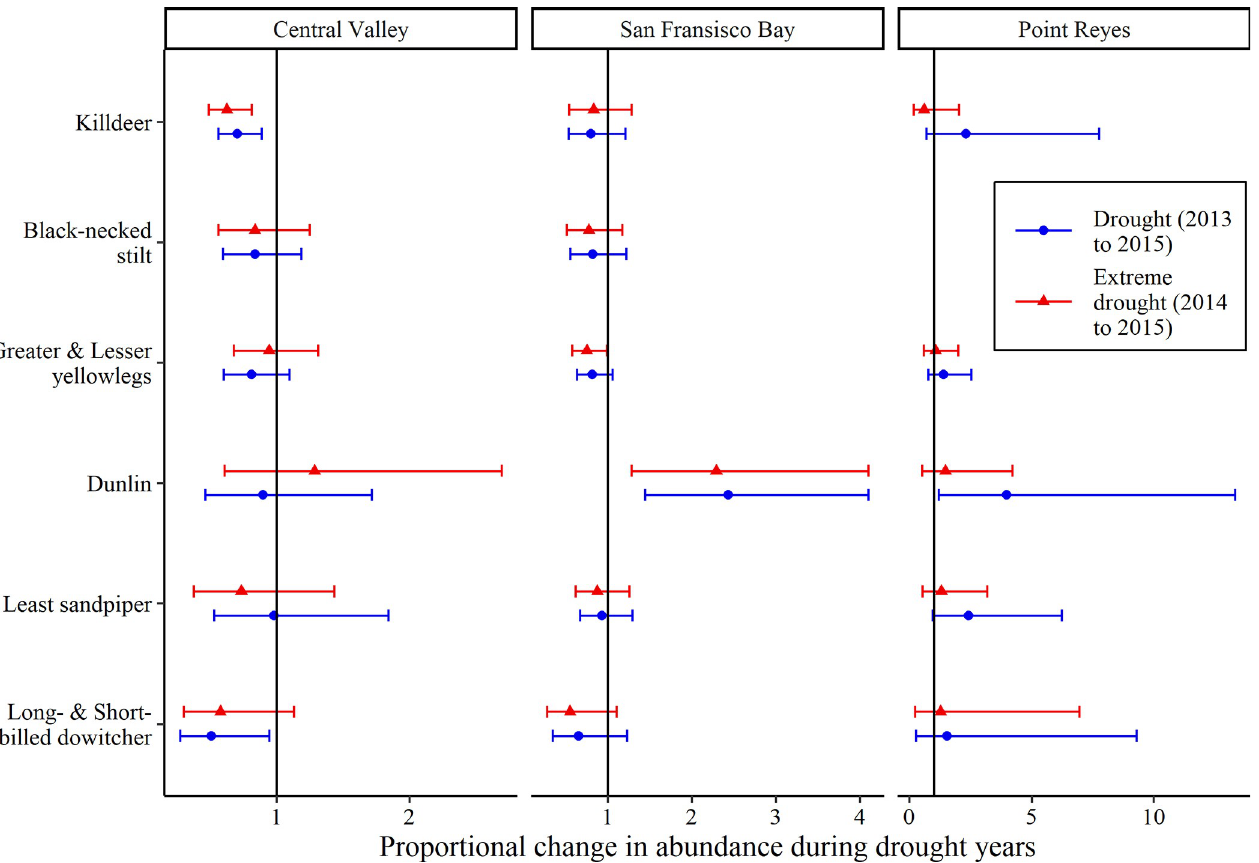
Fig 3. Estimated abundance for six focal species during a drought year in central California, USA. Results from generalized linear mixed models of the annual abundance of six shorebirds from 2011 to 2016 in three regions of central California, USA. Plots for each region show the estimated proportional change in total shorebird abundance relative to a non-drought year from two models; drought models classified drought years as a period of a 3-year drought (2013–2015) or 2-year extreme drought (2014–2015). The solid black line represents no change from the estimated abundance of total shorebirds during a non- drought